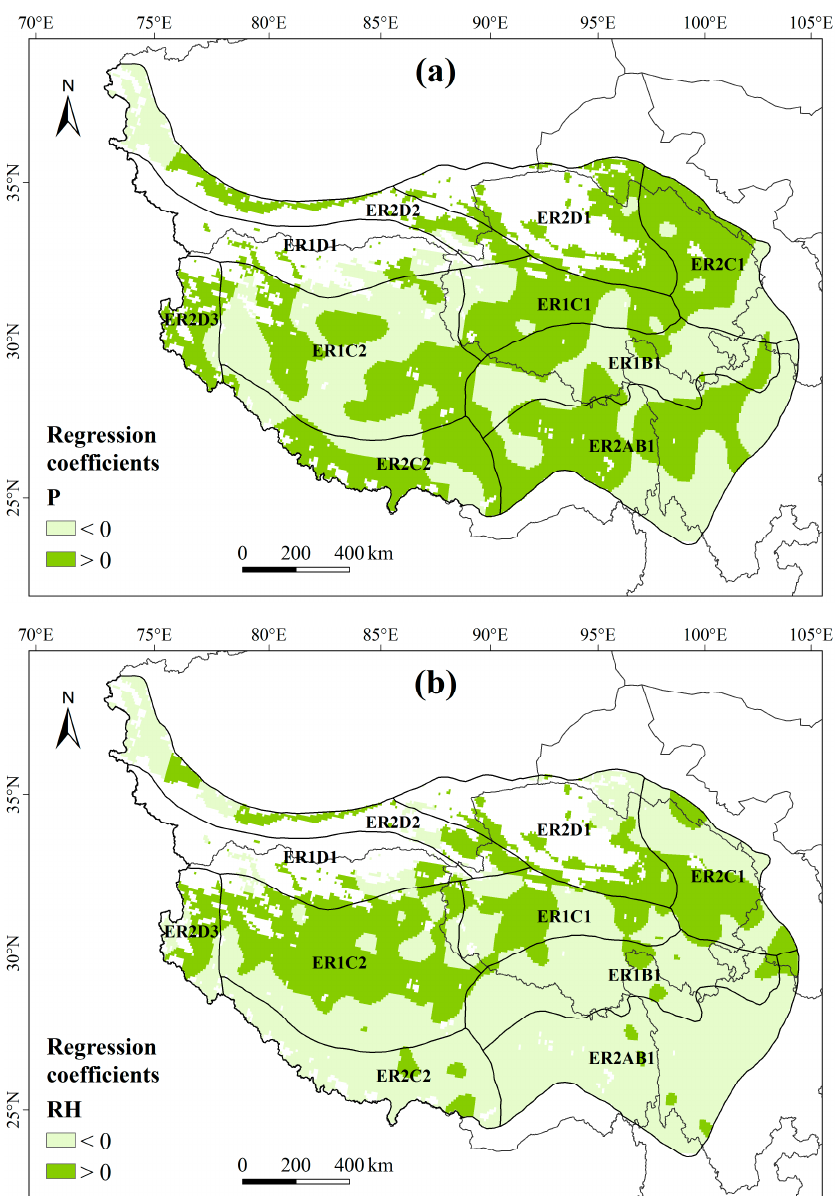
Figure 7. The spatial regression coefficients between NDVI variability and moisture variability (( a ): P ; ( b ): RH ) from the geographically weighted regression